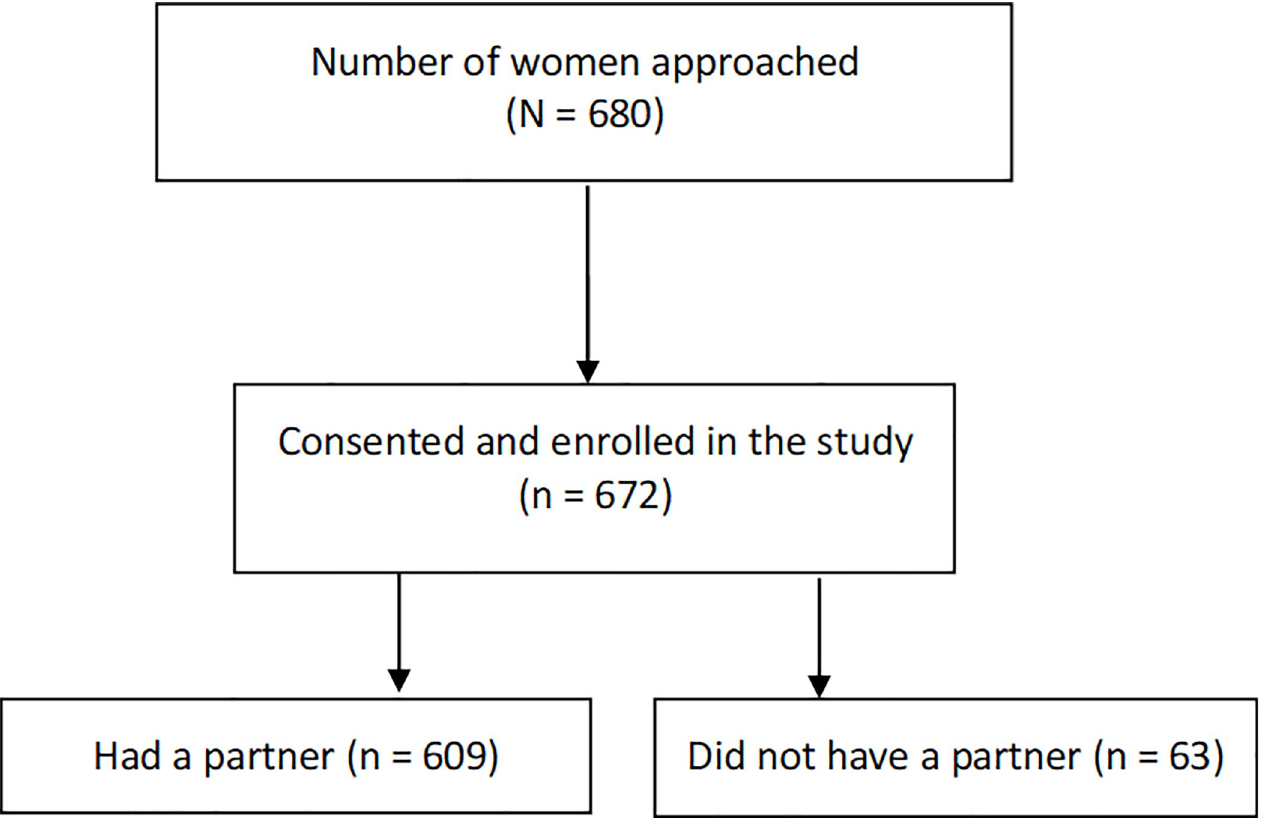
Fig 1. Flow diagram of distribution of the